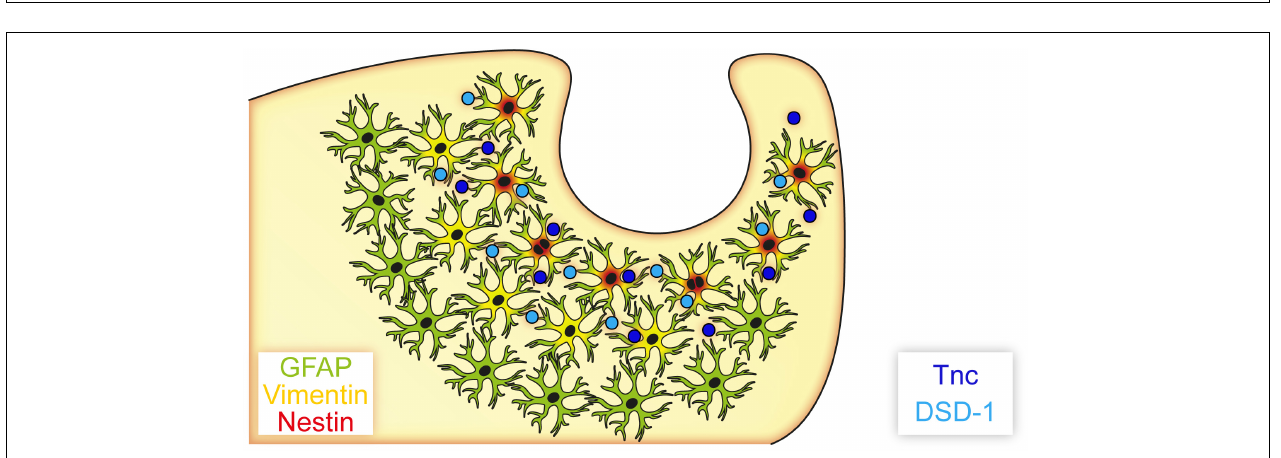
FIGURE 9 | PNNs in the lesioned visual cortex. (A–A (cid:48)(cid:48)(cid:48) ) WFA intensely stained PNNs in the penumbra 3 dpl. Aggrecan (Acan) signals appeared more diffuse. (B–B (cid:48)(cid:48)(cid:48) ) The same was observed 28 dpl, when morphologically intact PNNs could still be detected. GFAP-positive astrocytes (B (cid:48) –B (cid:48)(cid:48)(cid:48) ) indicate the high degree of reactive gliosis in the region where the PNN markers were still detectable. Asterisk: direction toward the lesion core; scale bar: 50 µ m.